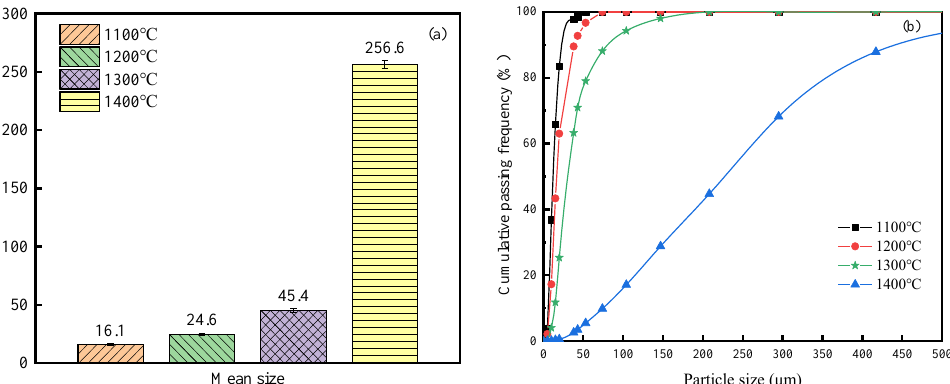
Figure 5. Effect of carbothermic reduction temperature on the size characteristics of ferronickel par- ticles: ( a ) mean size; ( b ) cumulative passing frequency distribution. particles: ( a ) mean size; ( b ) cumulative passing frequency